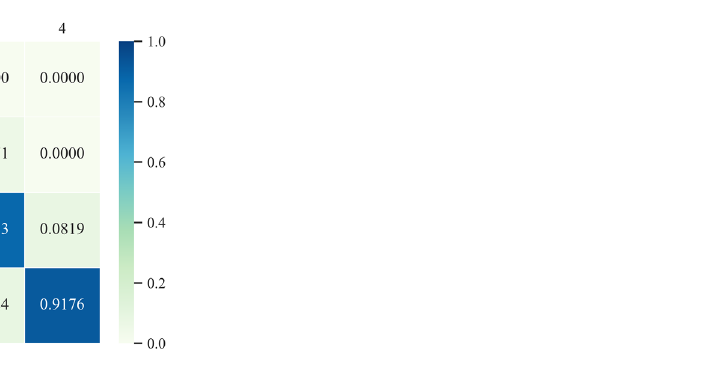
Table 2. Global Moran’s I of CEI in the YRB from 2007 to